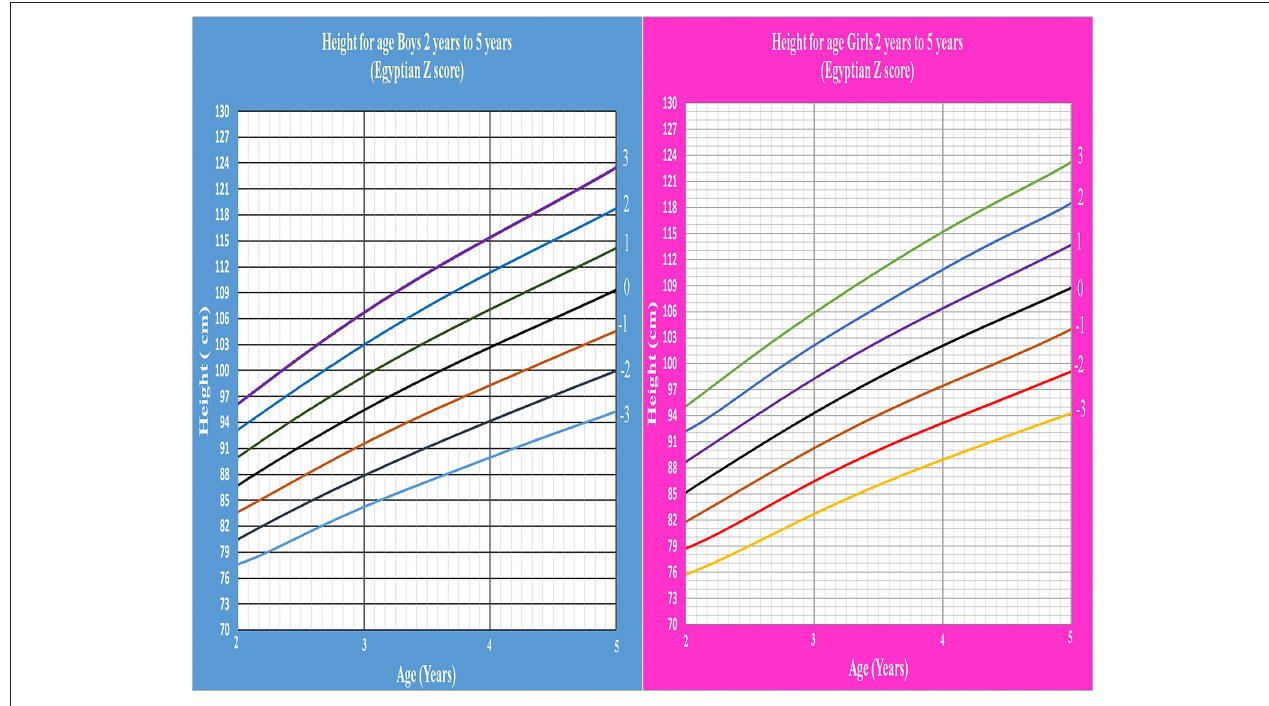
FIGURE 4 | Egyptian Z score height for age from 2 to 5 years for boys & girls.